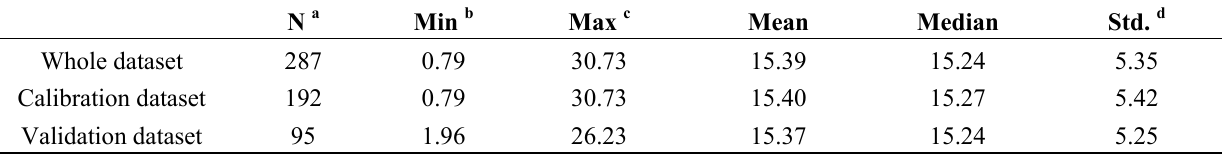
Table 3. Statistical descriptions of the soil organic carbon (SOC) contents (g·kg − 1